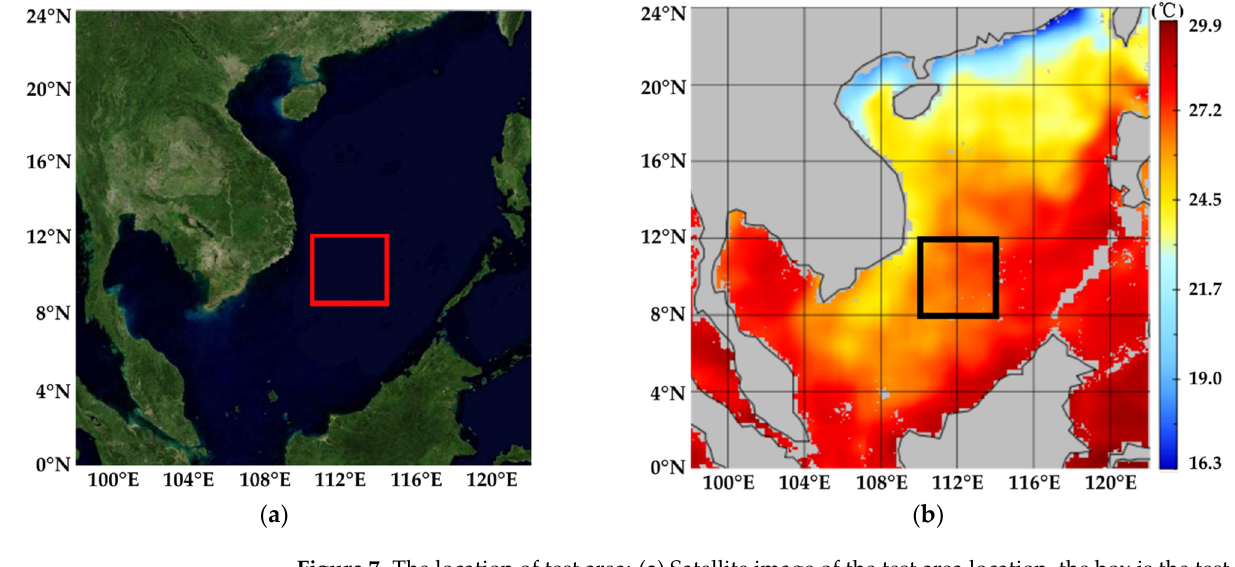
Figure 7. The location of test area: ( a ) Satellite image of the test area location, the box is the test area; ( b ) SST map of the test area location, the box is the test area.